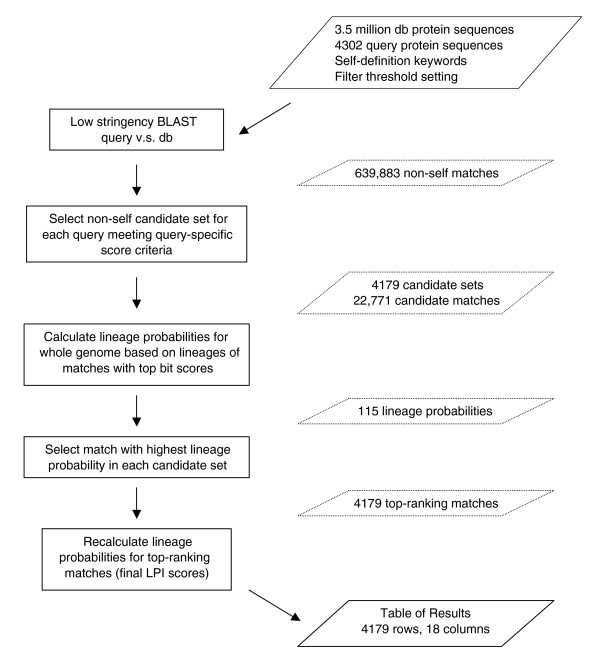
Flow diagram illustrating DarkHorse work flow, with example numbers for Escherichia coli strain K12. Parallelograms indicate data, rectangles indicate processes. Parallelograms with dashed borders indicate intermediate data, output by one step and input to the next step.